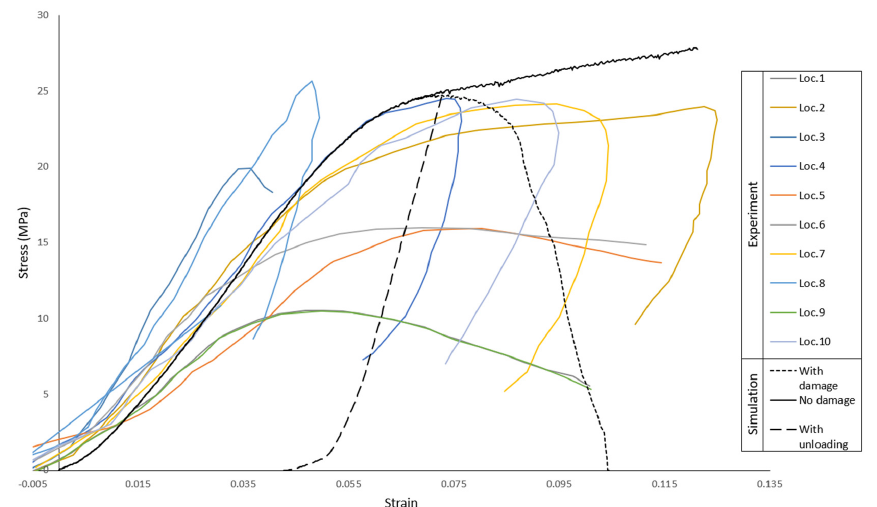
Figure 10. Damage model influence, with and without unloading in comparison with the experiments from all the locations.